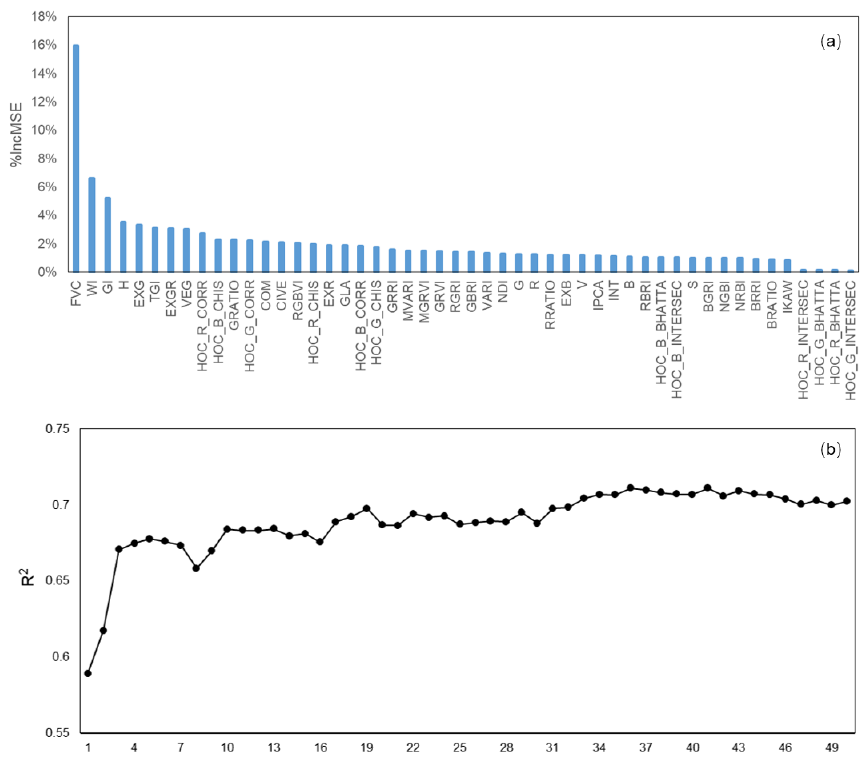
Figure A2. The important values for each independent variable (a) and the R 2 results of the different number of input variables at the quadrat scale (b) .